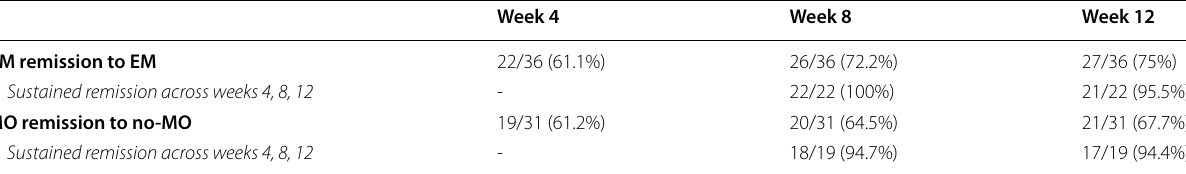
Table 2 Patients remitting from chronic migraine (CM) to episodic migraine (EM) and from medication overuse (MO) to no medication overuse (no-MO) across weeks 4, 8 and 12 following fremanezumab